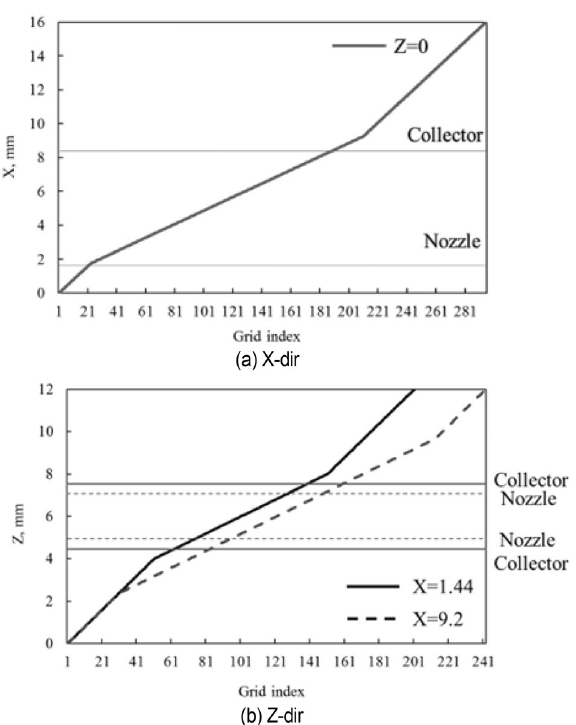
Figure 7. The mesh distribution in the plenum chamber.